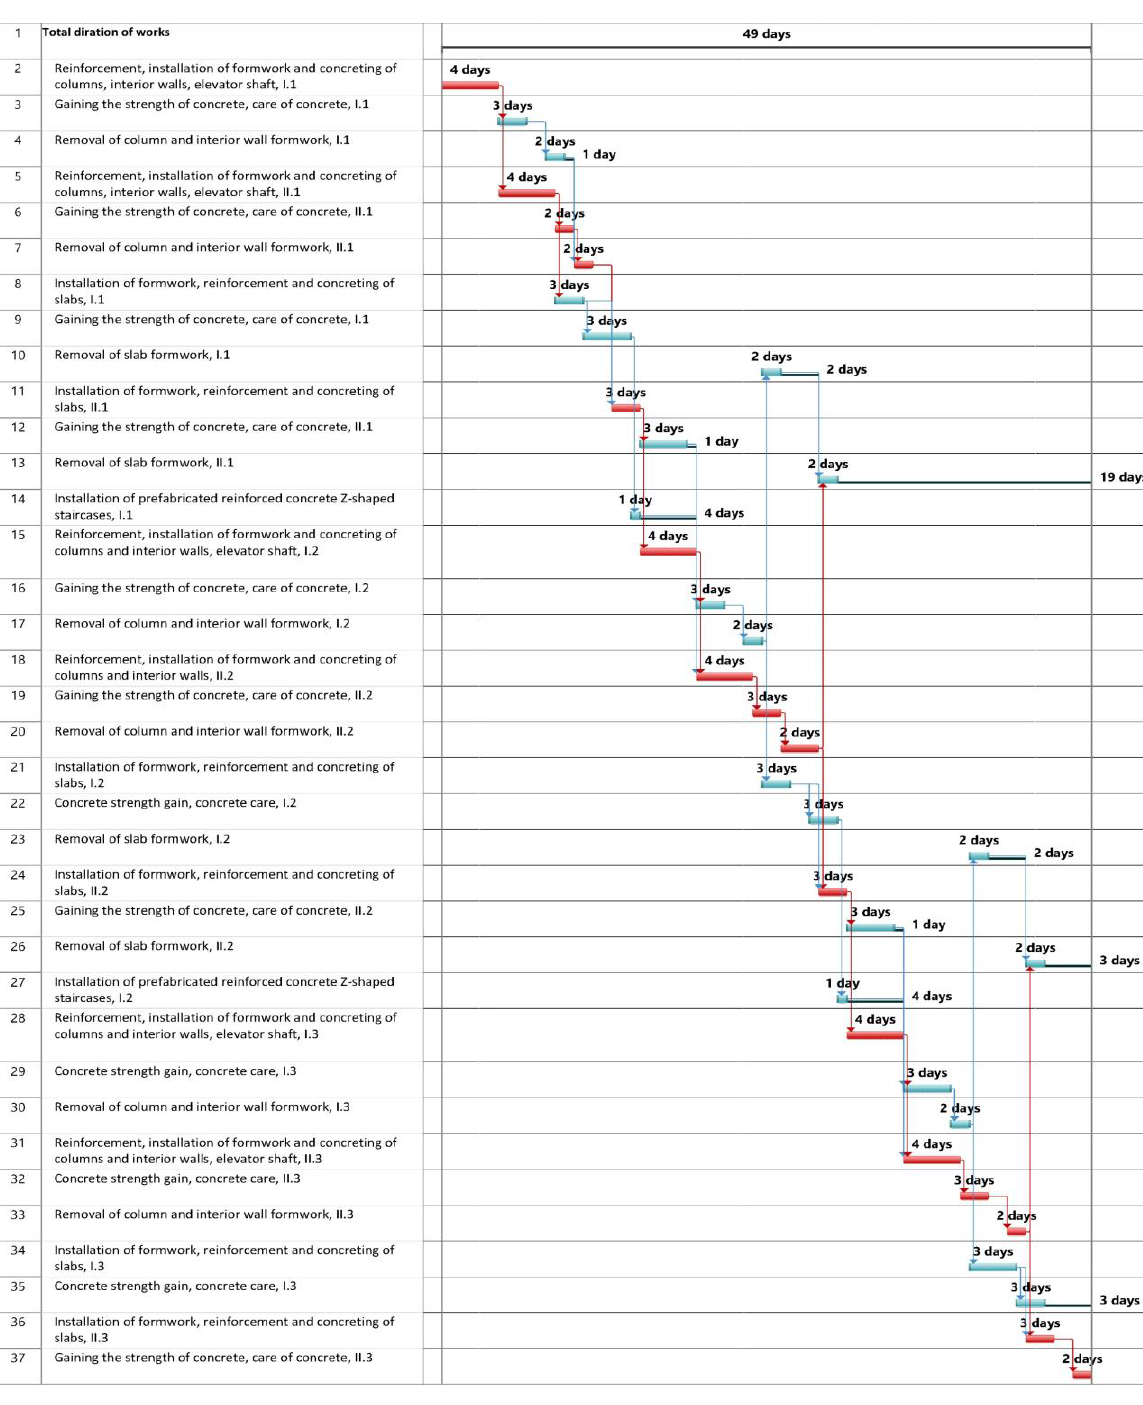
Figure 10. Schedule model No. 2 developed for the construction of a reinforced concrete building frame.